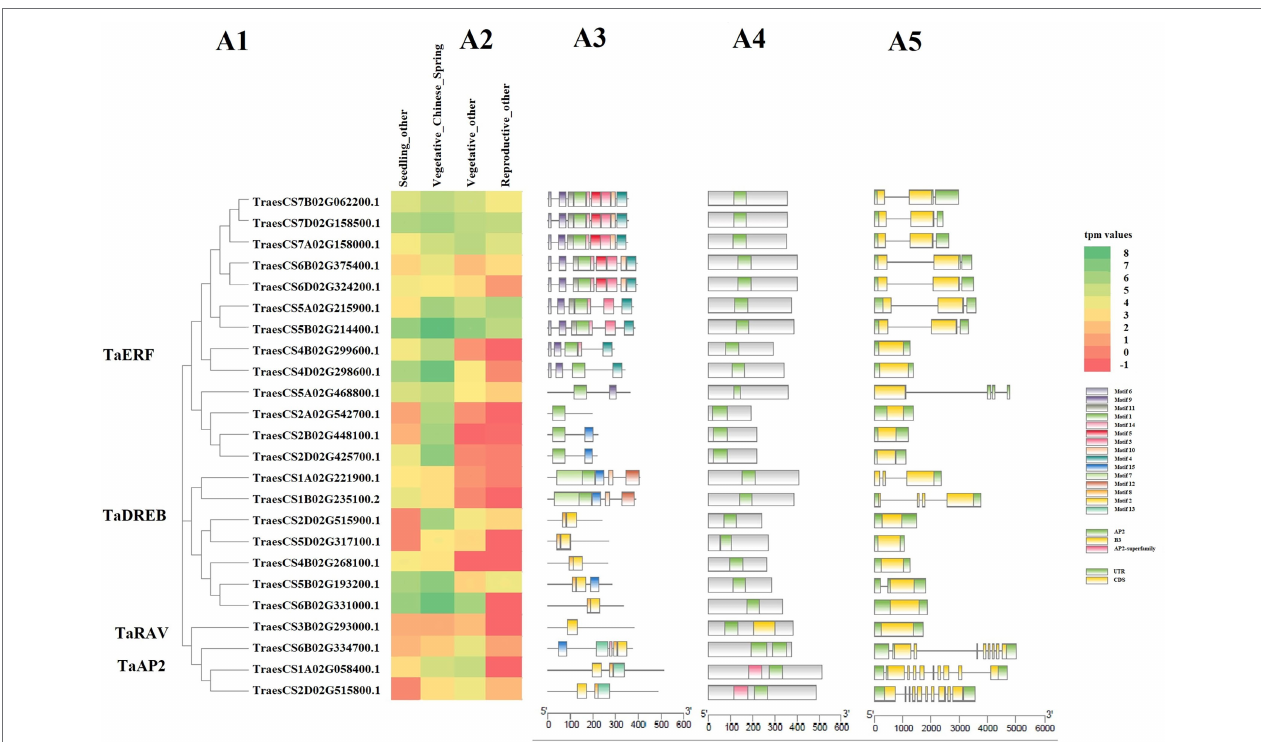
FIGURE 5 | Heatmap showing the expression pattern of selected 24 TaAP2/ERF TF genes under abiotic stress using wheat expression transcriptome data (A2) , along with their conserved motif composition (A3) , protein domains (A4) , gene structure (A5) , and phylogenetic distribution (A1) . In the heatmap, the intensity of color shows the level of gene expression, where the red color shows the least expressed gene, and the green color shows the highest expressed gene. In the motif graph, the colored blocks represent the positions of motifs in corresponding proteins coding TF genes, block size indicates the length of motifs and grey lines connecting the colored bocks represent the non-conserved sequences. In the protein domain graph, the green blocks represent the AP2 domain, yellow blocks represent the B3 domain, and pink blocks represent the AP2 superfamily domain. In the gene structure graph, the yellow blocks are exons, green blocks are UTR, and grey lines are introns. The relative position of each motif, domain, and exon, intron, and UTR can be determined with the help of scale displayed just below the corresponding graph.